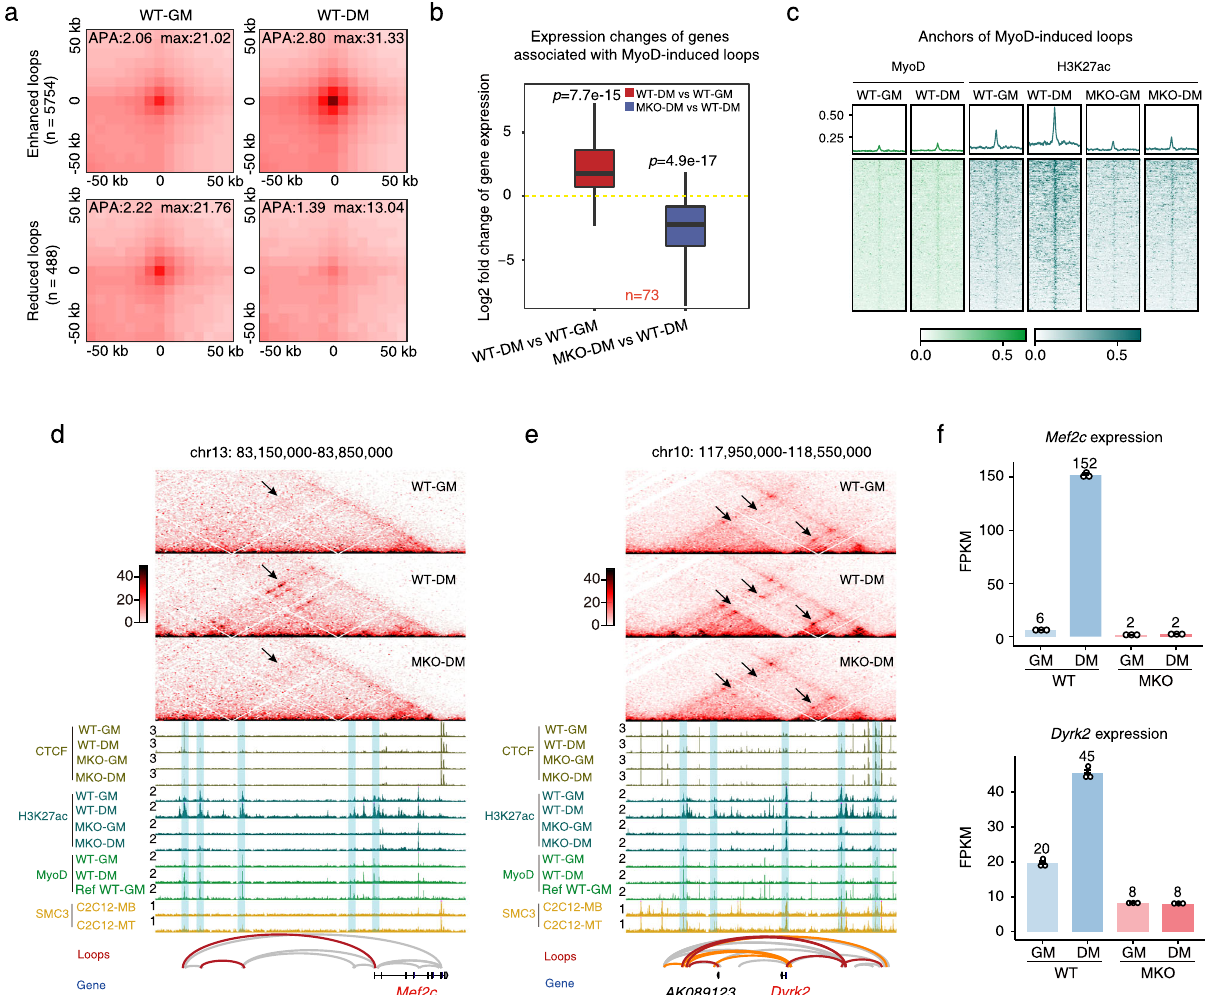
Fig. 6 The regulatory loops speci fi ed by MyoD are functionally required for muscle cell differentiation. a APA plots showing the aggregated Hi-C contacts around chromatin loops that are enhanced ( n = 5754) and reduced ( n = 488) in WT-DM cells compared with WT-GM cells. Differential loops were identi fi ed based on DESeq2 (see Methods). b Boxplot showing expression changes of genes associated with MyoD-induced chromatin loops in WT- DM cells compared with WT-GM cells (left) and in MKO-DM cells compared with WT-DM cells (right). The gene numbers related to the MyoD-induced loops are marked in red. p -values were calculated by the one-sided Wilcoxon rank-sum test. Source data are provided as a Source Data fi le. c MyoD and H3K27ac ChIP-seq signals at the anchors of MyoD-induced loops. Heatmaps showing signal enrichment centralized at the anchors within a ± 100 kb genomic region. d , e The Mef2c and Dyrk2 loci as representatives of MyoD-induced loops occurring during muscle cell differentiation. The MyoD-induced loops detected by our algorithm are presented in red in the loop track, while differentiation-induced loops are shown in orange. Other loops are presented in gray. f Mef2c and Dyrk2 gene expression among WT and MKO cells cultured in GM and DM. Data are presented as mean ± SD. n = 3 biologically independent